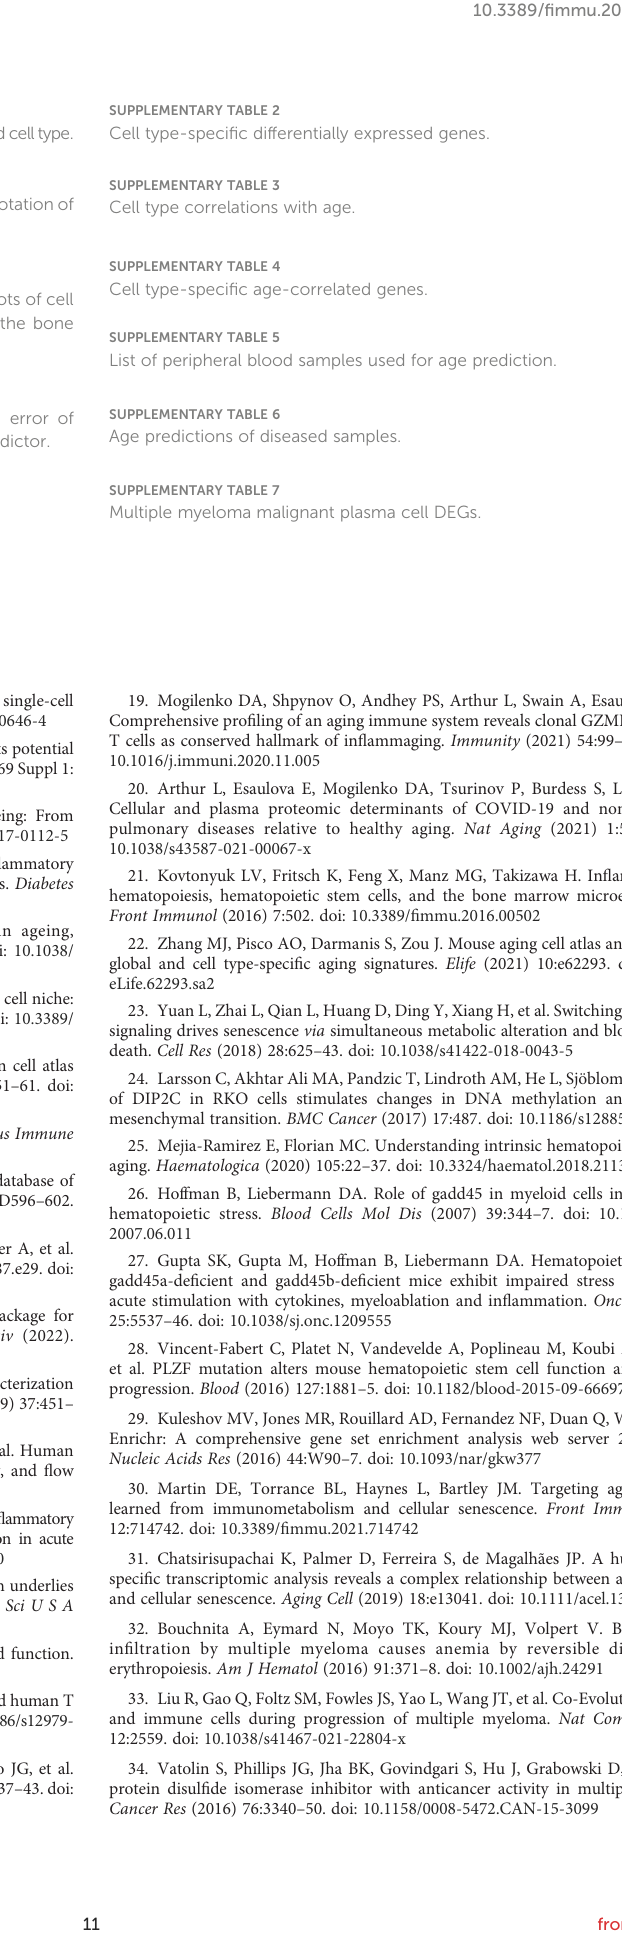
SUPPLEMENTARY TABLE 4 Cell type-speci fi c age-correlated genes. SUPPLEMENTARY TABLE 5 List of peripheral blood samples used for age prediction.